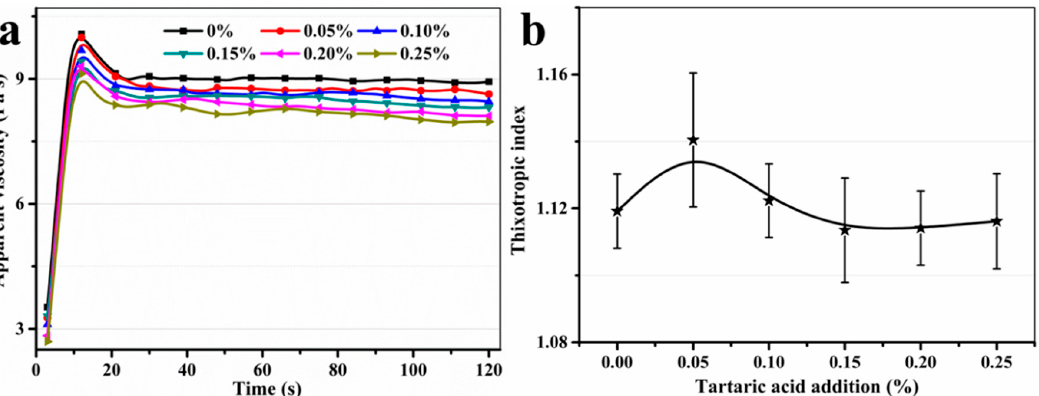
Figure 5. ( a ) The apparent viscosity and ( b ) thixotropic index of fresh SAC paste with different additions of TA under a constant shear rate of 100 s − 1 .